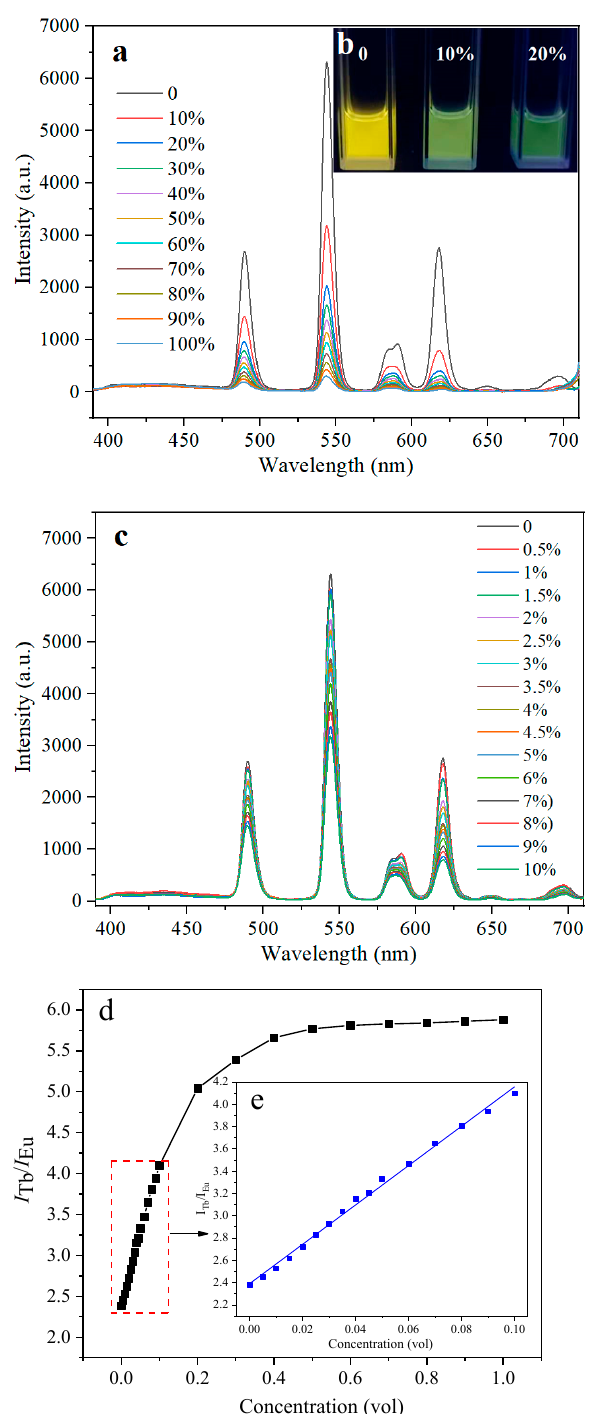
Figure 8. Fluorescence spectra of Eu/Tb-PMA-MPEG in DMF with water content from 0% to 100% ( a ); photographs of Eu/Tb-PMA-MPEG in DMF with water content 0%, 10% and 20% under 365 nm UV light ( b ); fluorescence spectra of Eu/Tb-PMA-MPEG in DMF with trace water from 0% to 10% ( c ); decreasing trend of I Tb / I Eu vs. water ( d ); I Tb / I Eu vs. water plots from 0% to 10% and the blue solid line represents the theoretical fit ( e ).